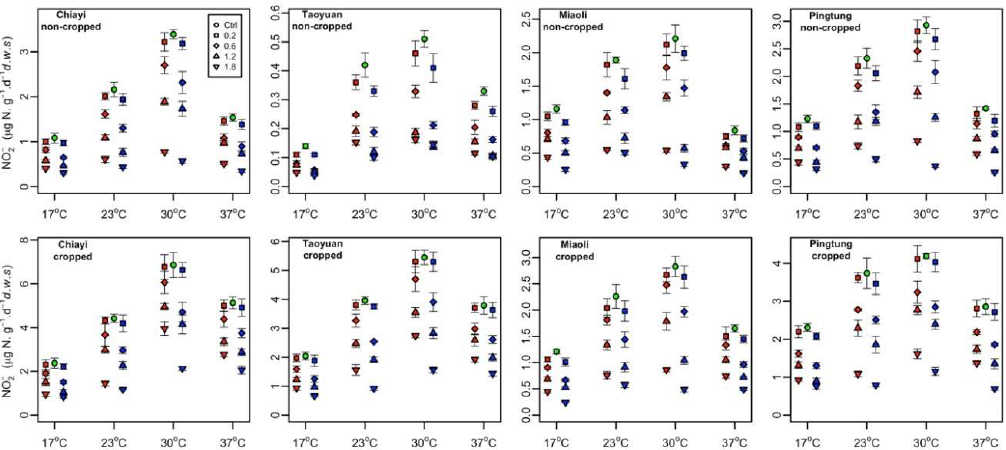
Figure 2. NO 2 − production after application of two nitrification inhibitors at four application rates over a temperature gradient. Red is dicyandiamide (DCD) and blue is 3,4-dimethylpyrazole phosphate (DMPP). Each point represents means (± standard error of mean) for three replications.